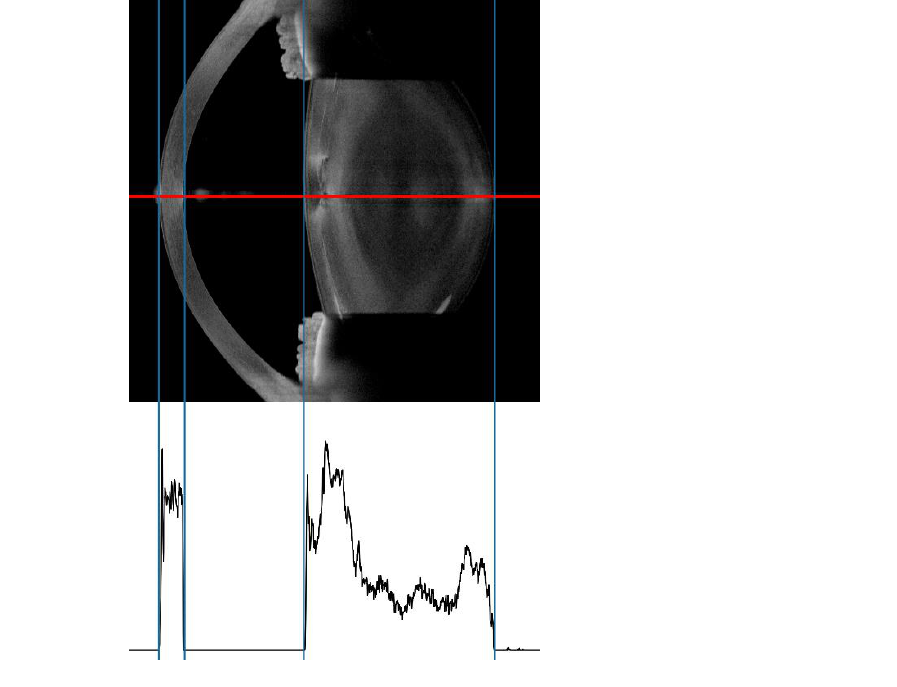
Figure 2. Linear density analysis using SS-OCT. The graph represents the intensity values along the red line (A-Scan). Linear density is calculated through the mean of the values between the 3rd and 4th blue line.